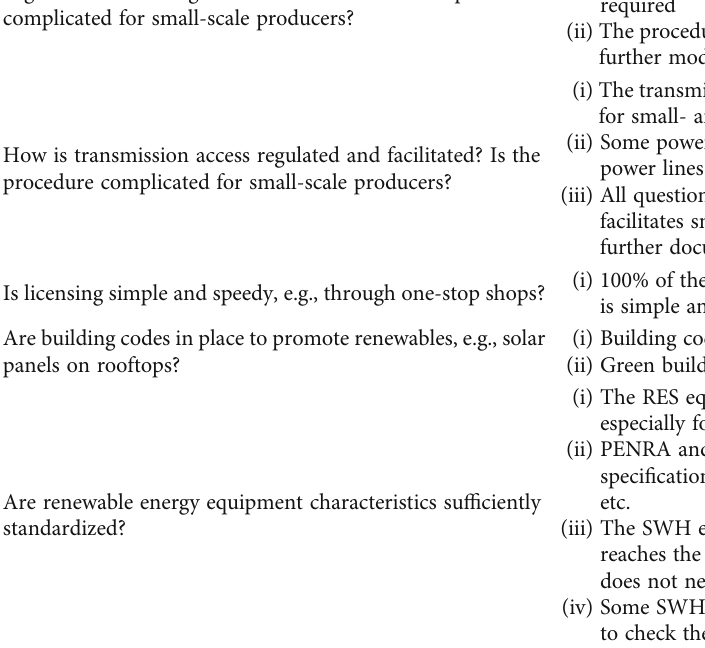
Table 4: Summarization of answers of public institutions to questions related to standardization, licensing, and planning for RES and EE. Is grid connection regulated and facilitated? Is the procedure complicated for small-scale producers?